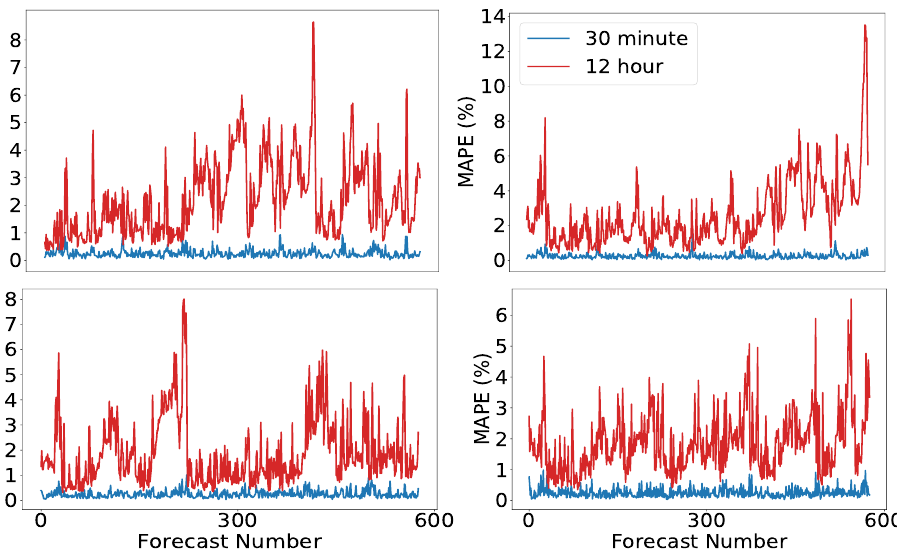
Figure 12. MAPE for models: ( Top ) 28 February–7 March test set; ( Bottom ) 27 October–4 November test set; ( Left ) best model; and ( Right )